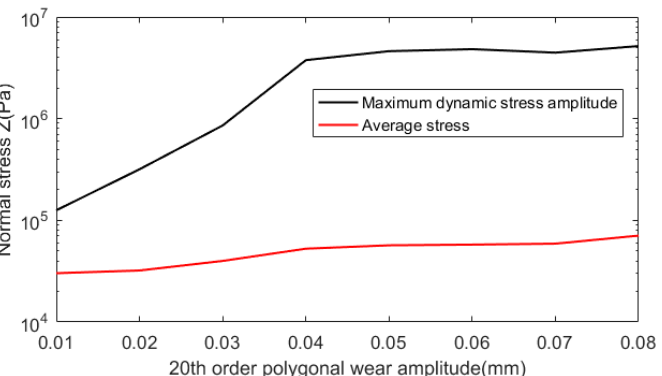
Figure 14. Dynamic stress of gearbox housing with the amplitude of 20th wheel wear.